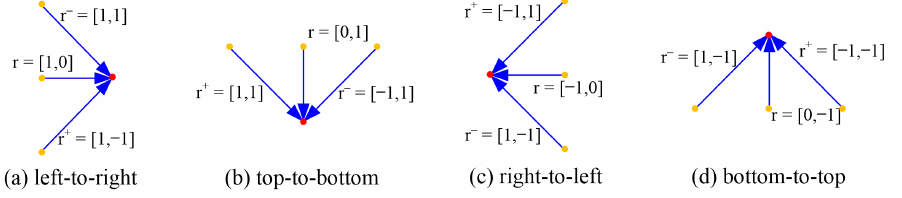
Figure 2. Directions of information propagation on each tree structure. Red node is the root node, and orange nodes are children